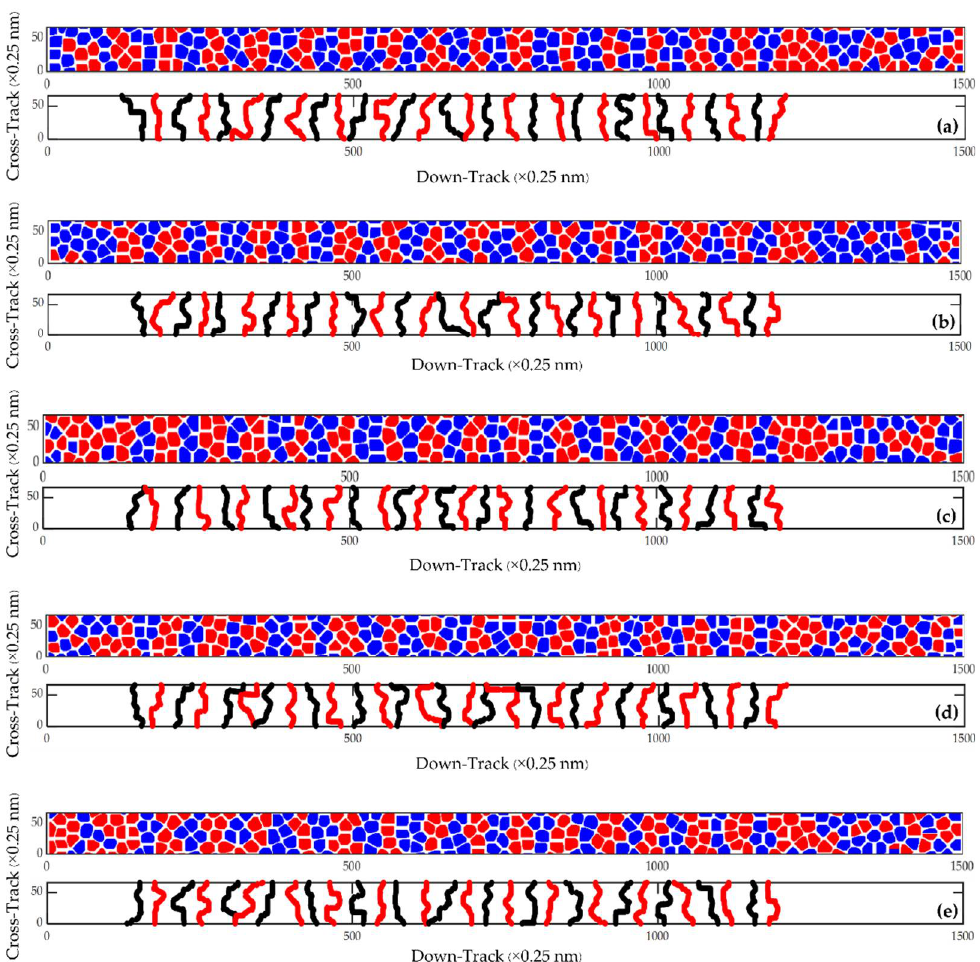
Figure 3. The magnetic footprints ( upper ) at a bit length of 9 nm with a track width of 16.5 nm and the boundary between bits ( lower ) of the ( a ) 1st, ( b ) 2nd, ( c ) 3rd, ( d ) 4th, and ( e ) 5th tracks.